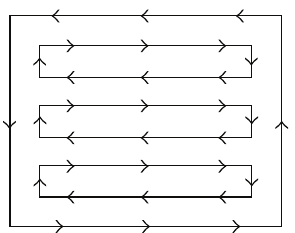
Figure 10: A redrawing of the connected diagram shown in Figure 9.